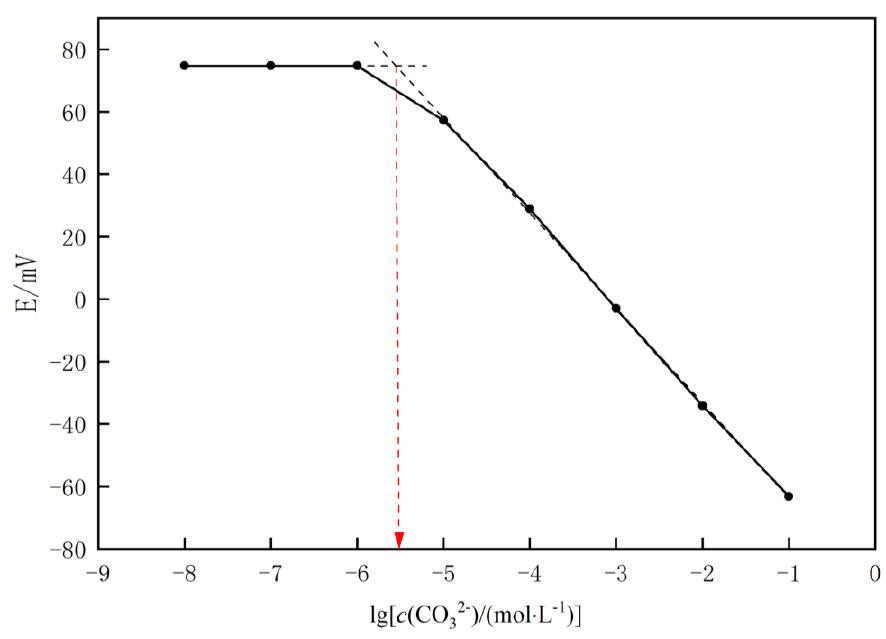
Figure 3. Electrode performance in 1 × 10 -8 –10 -1 M Na 2 CO 3 solution.